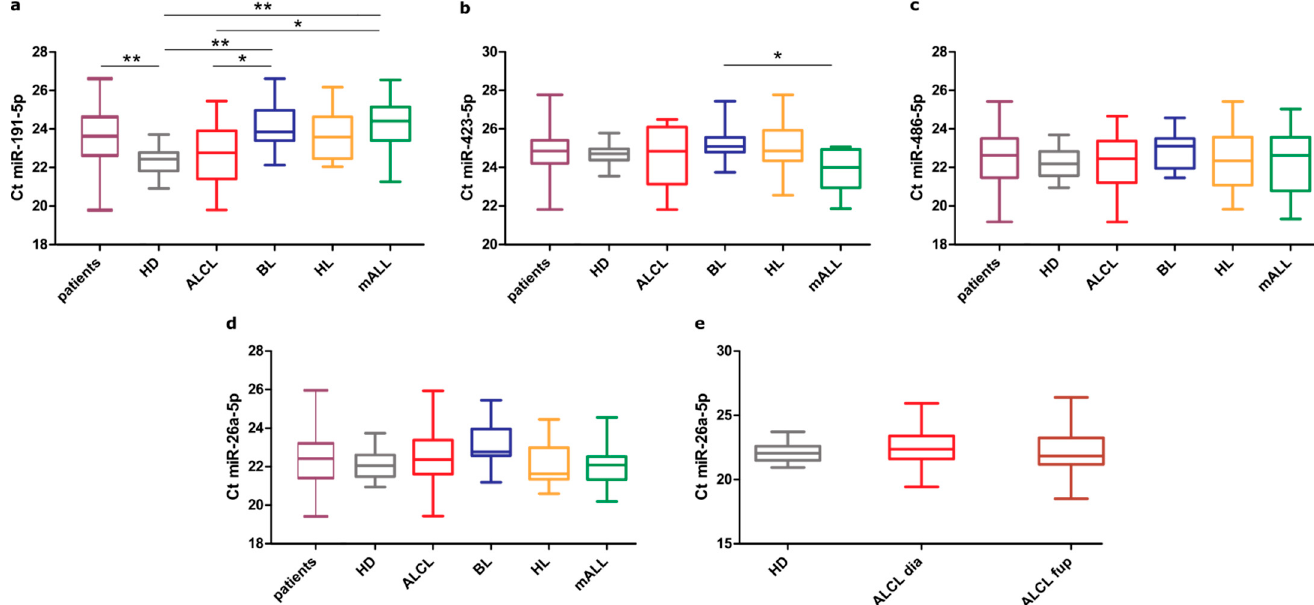
Figure 2. Expression (Quantitative real-time polymerase chain reaction (qRT-PCR) Ct values) of candidate reference miRNAs in plasma exosomes from healthy donors (HDs), representing control samples, and from pediatric patients with different hematological malignancies (ALCL: anaplastic large cell lymphoma; BL: Burkitt lymphoma; HL: Hodgkin lymphoma; mALL: mature B-cell acute lymphoblastic leukemia). ( a – d ) Ct of samples from HDs compared with patients considered altogether (patients) and separately, by disease. Ct distribution of normally distributed values (miR-486-5p, miR26a-5p and miR-191-5p) were compared by unpaired t-test or Tukey test, whereas miR-423-5 p values were compared by nonparametric Mann–Whitney or Dunn’s test. ( e ) Expression of miR-26a-5p in HD, ALCL at diagnosis (ALCL dia) and at follow up (ALCL fup). Only the statistically significant differences of Cts are marked. *: p < 0.05; **: p <